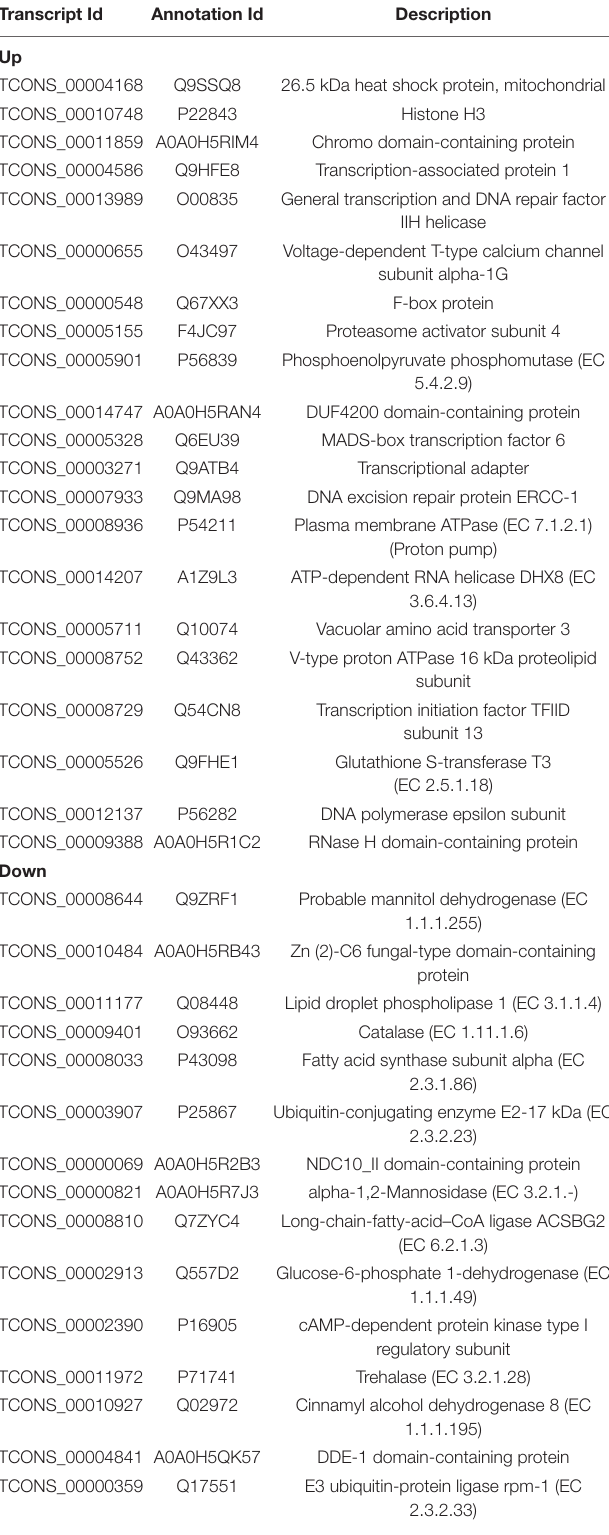
TABLE 2 | DEGs with known role in the germination of resting